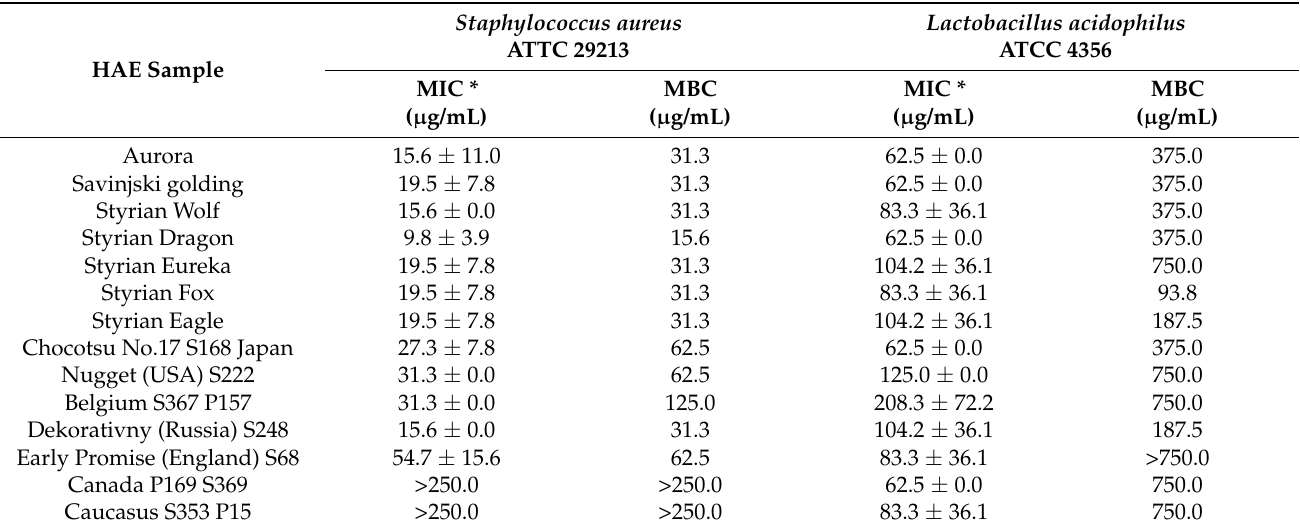
Table 4. The MIC and MBC values of investigated hydroacetonic hop extracts (HAE) determined against Staphylococcus aureus and Lactobacillus acidophilus